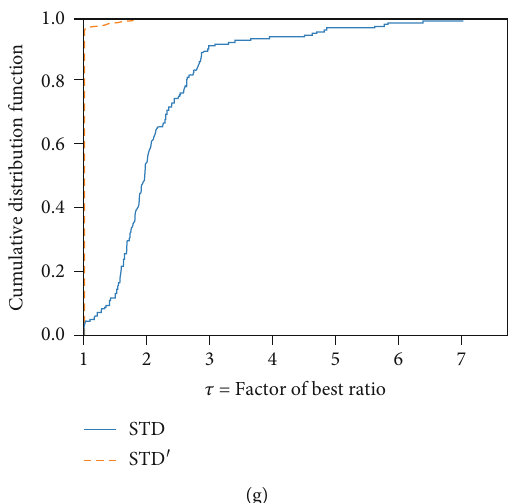
Figure 1: Performance pro fi les based on relative CPU time (s) for Question 1. (a) BLSP, (b) QMKP with positive coe ffi cients, (c) QMKP with mixed-sign coe ffi cients, (d) k QKP with positive coe ffi cients, (e) k QKP with mixed coe ffi cients, (f) HSP, (g) QSAP.